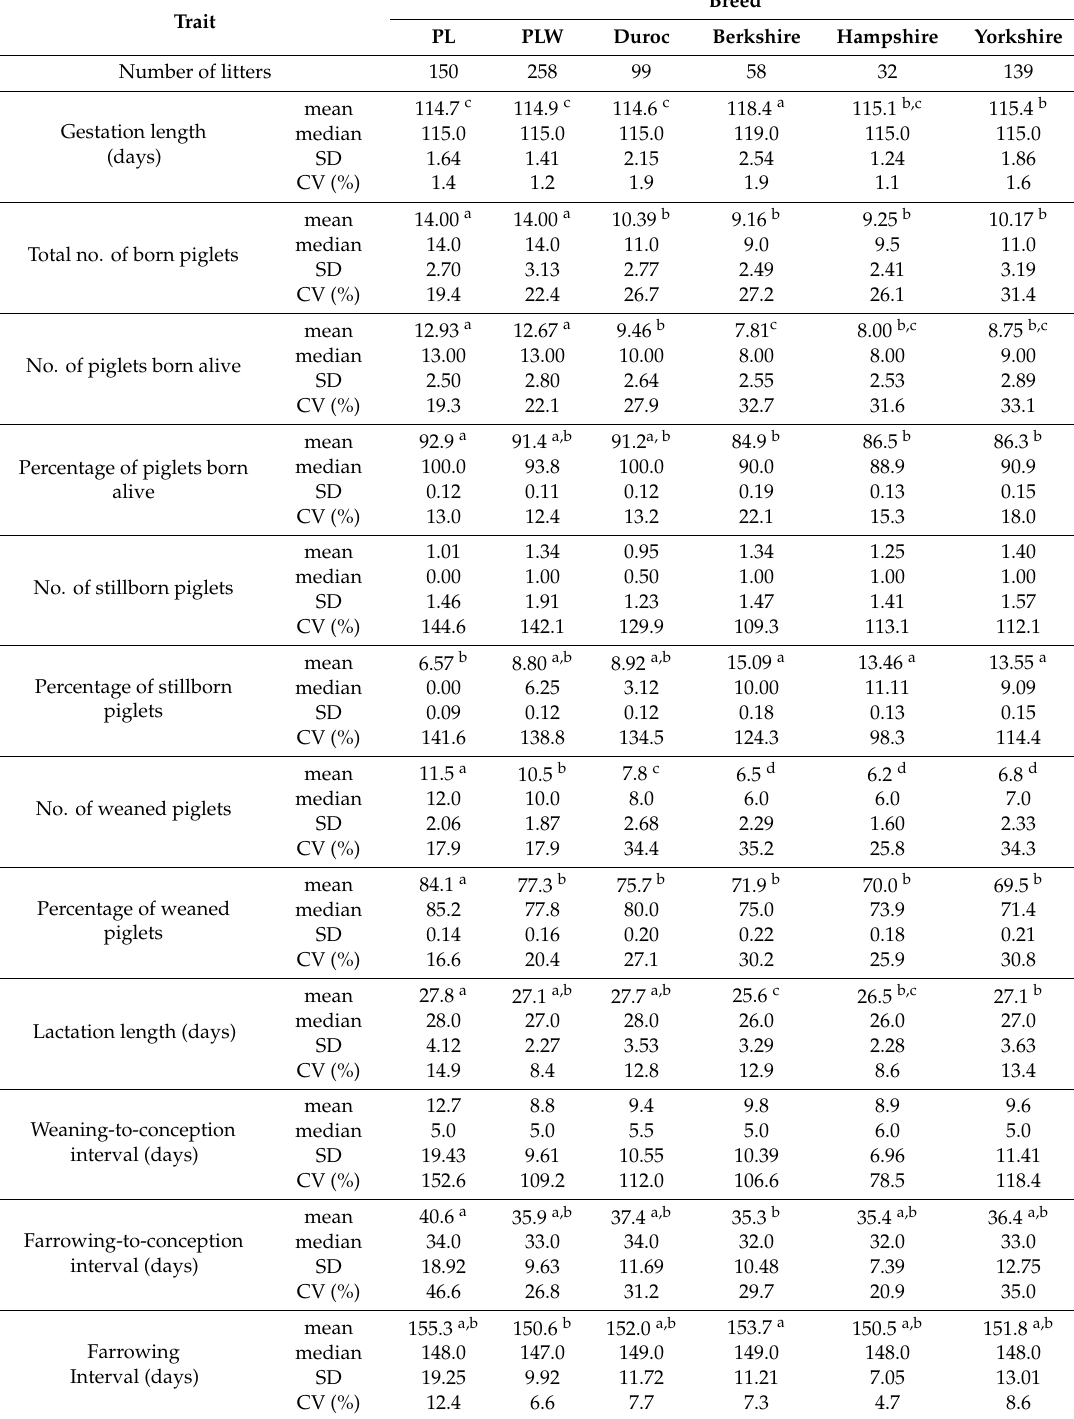
Table 3. Summary statistics for the analyzed reproductive traits of sows of the breeds studied. Trait